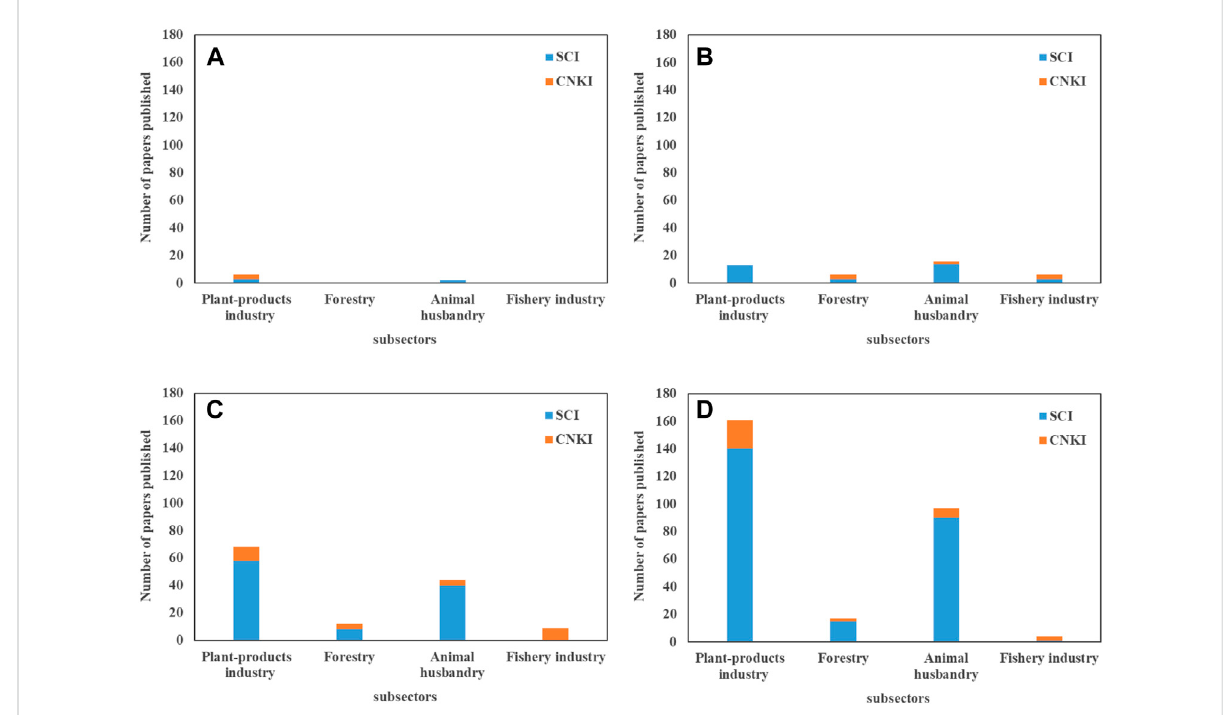
footprint were selected and the modular function in Gephi was used for cluster analysis. The analysis results were shown